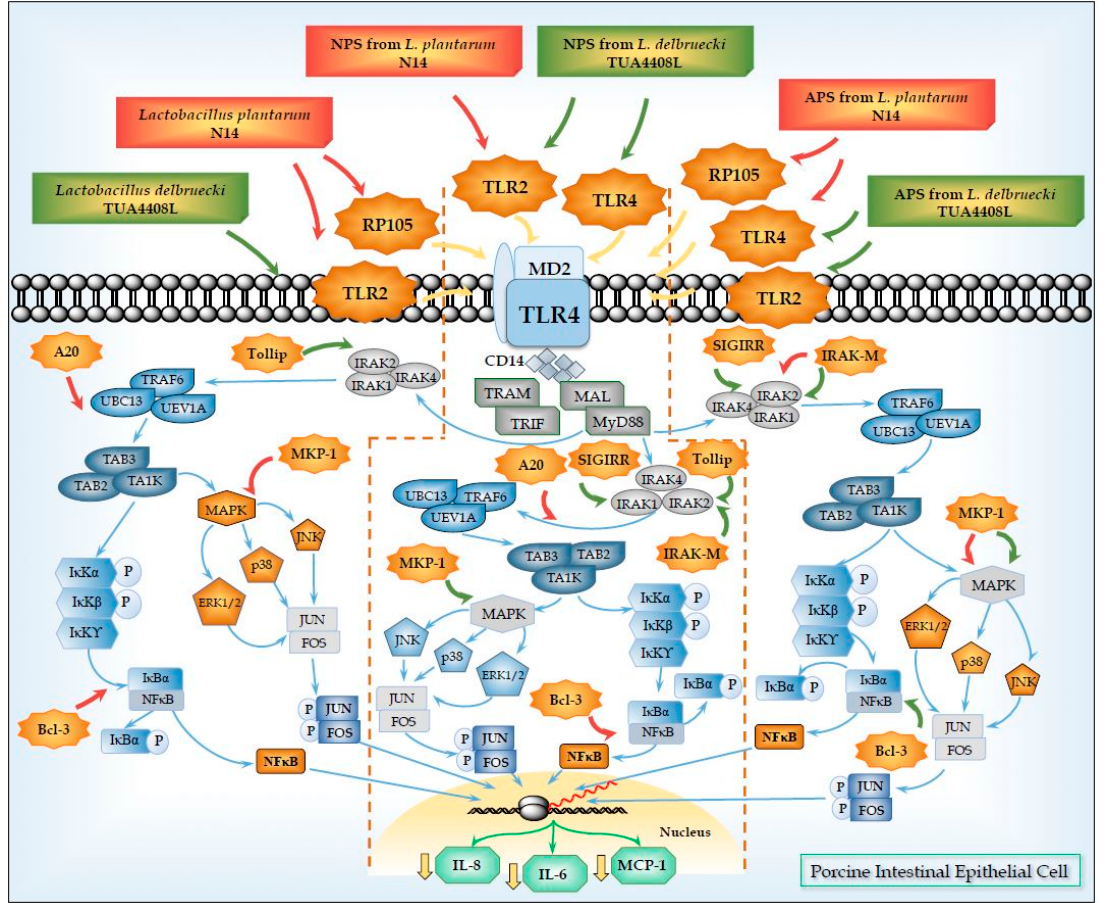
Figure 2. Modulation of Toll-like receptor 4 (TLR4) signaling pathway in porcine intestinal epithelial (PIE) cells by acidic (APS) and neutral (NPS) exopolysaccharides produced by Lactobacillus plantarum N14 and Lactobacillus delbrueckii TUA4408L. Treatment of PIE cells with L. plantarum N14, L. delbrueckii TUA4408L or their APS and NPS induce the expression of TLR negative regulators TOLLIP, IRAK-M, SIGIRR, MKP-1, A20, and/or Bcl3 via TLR2, TLR4, and/or RP105. Treated-PIE cells